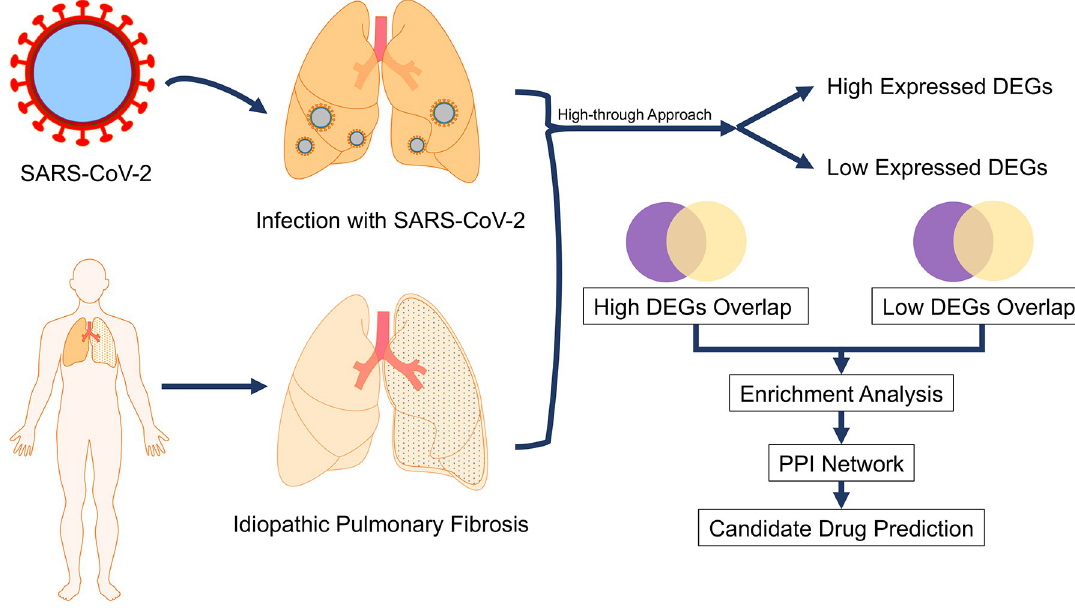
Fig 1. The workflow of the current